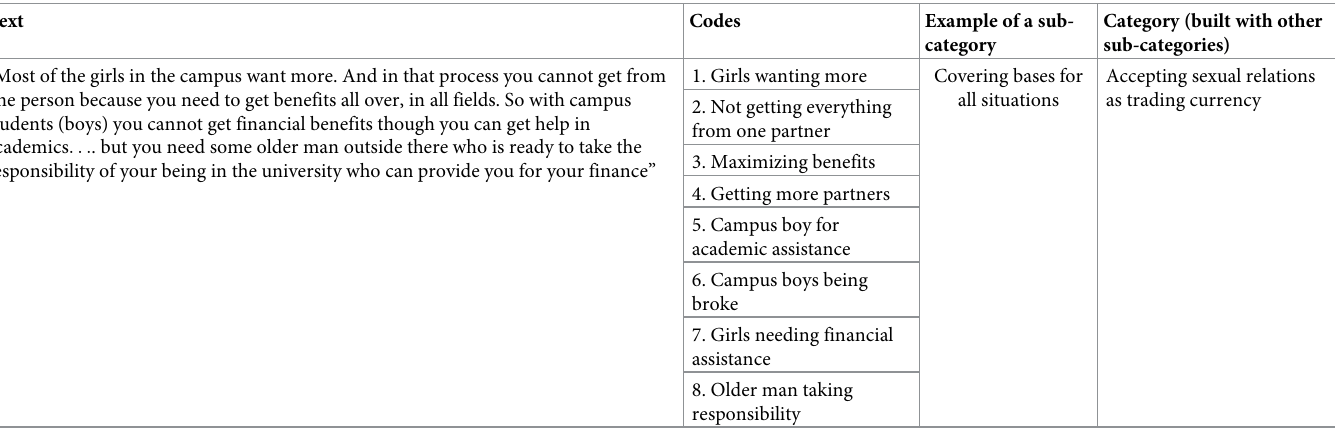
Codes Example of a sub-